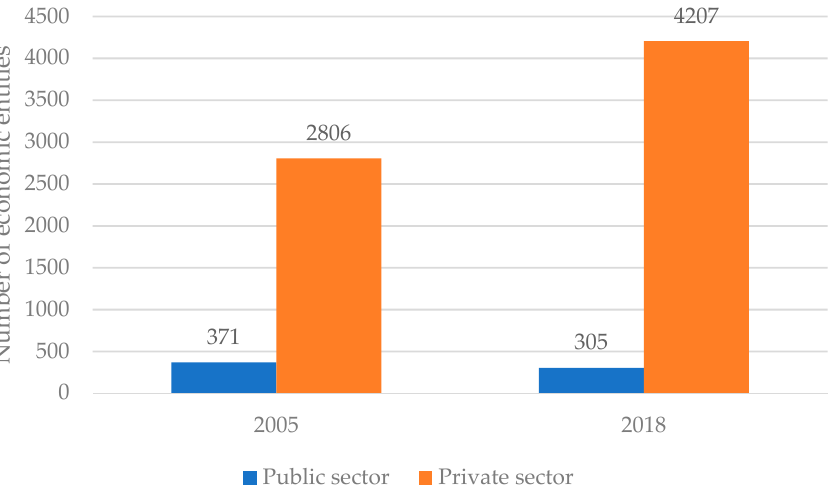
Figure 4. Economic entities operating in the raw materials recovery sector in Poland in 2005–2018. Source: own based on [40].